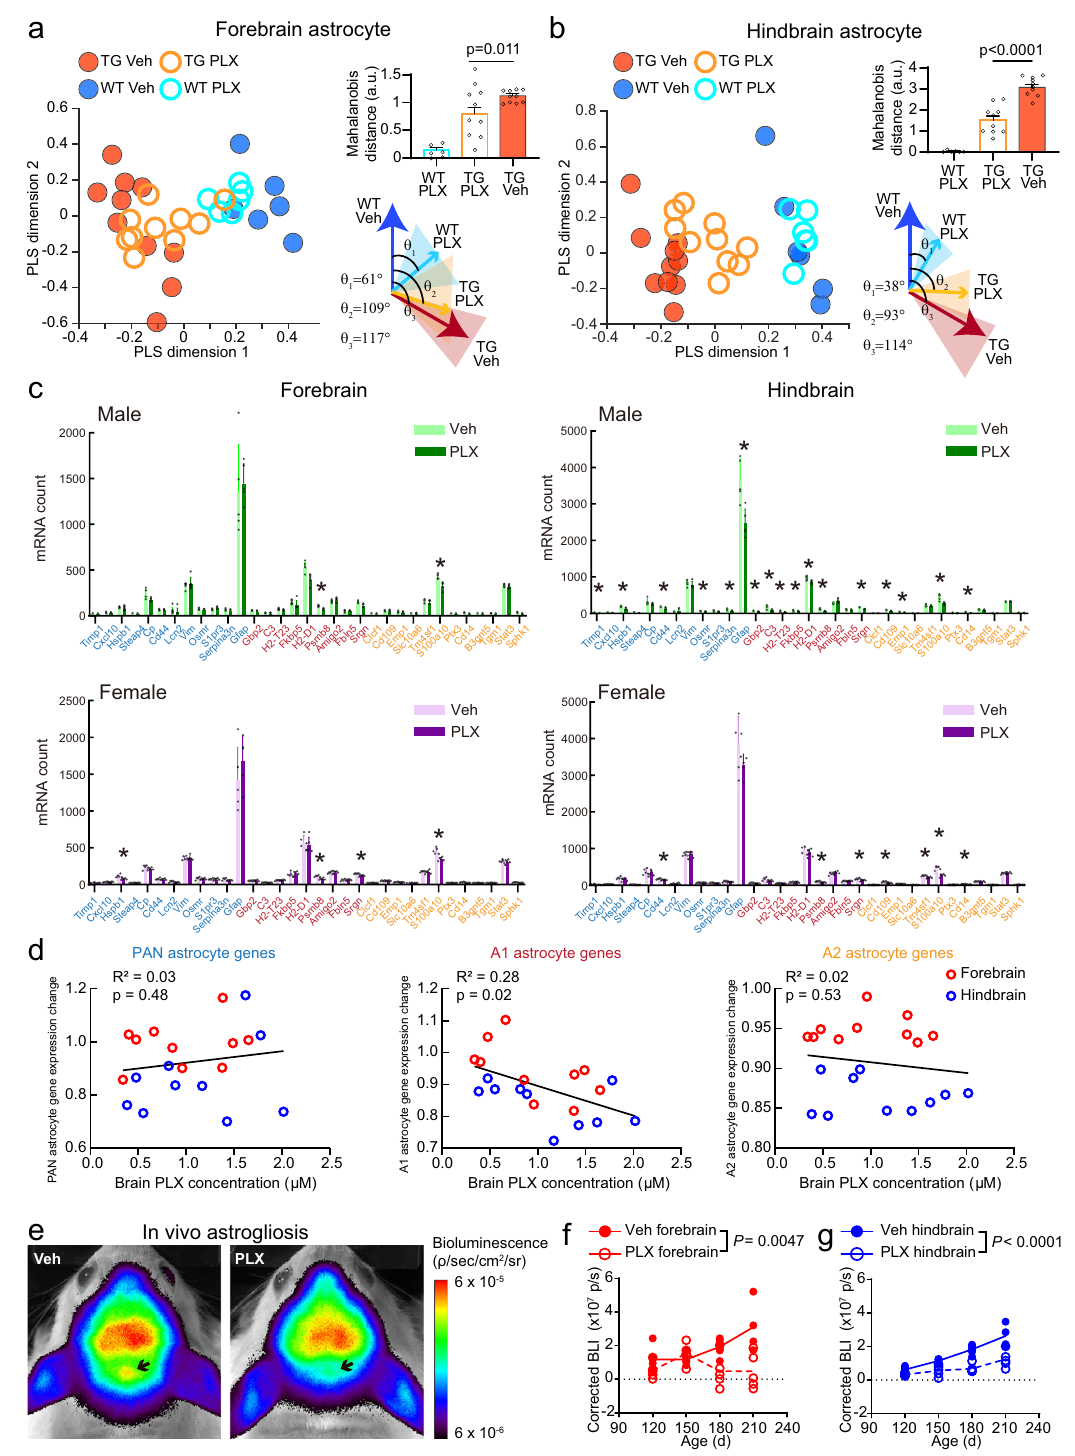
Fig. 8 | CSF1R inhibition ameliorates tau-induced pathological astrocyte acti- vation. a , b Analyses similar to Fig. 6c – e using astrocyte-speci fi c genes (47 genes in eachmouse)in( a )forebrainand( b )hindbrainregions.Forothercelltypesandbrain regions, see Supplementary Fig. 12. In ( a and b ), data are presented as mean±S.D., Mann – Whitney tests were used for comparison. c Quanti fi cations of featured astrocyte genes in different conditions. Data are represented as mean±S.D. Two- sided t -tests were used to compare vehicle and PLX-treated groups for each gene, with 5% false discovery rate correction for multiple comparisons. Asterisks indicate P <0.05. d Correlation of brainPLXconcentrationand different groups of astrocyte gene expression. Based on a prior study 46 , A1 genes are associated with neurotoxic astrocytes following lipopolysaccharide exposure and A2 genes are associated with